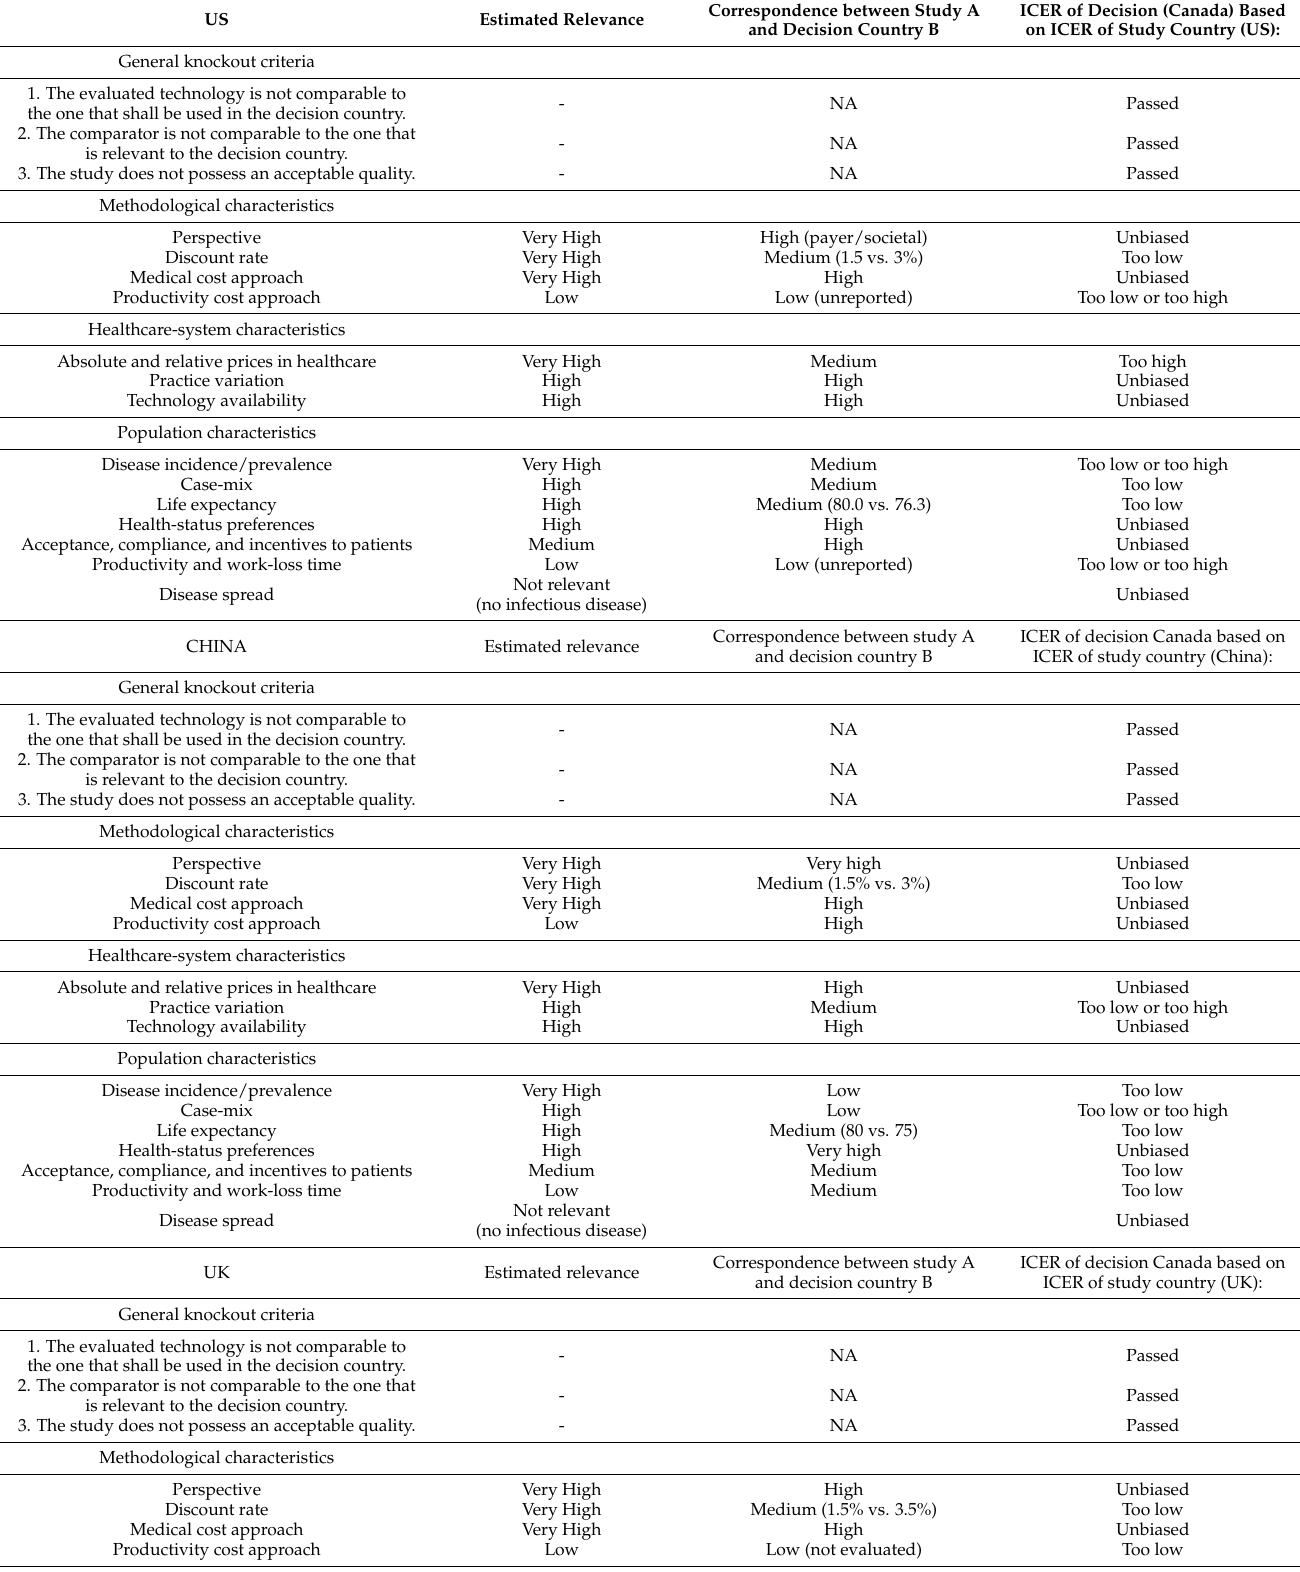
Table A4. Transferability assessment